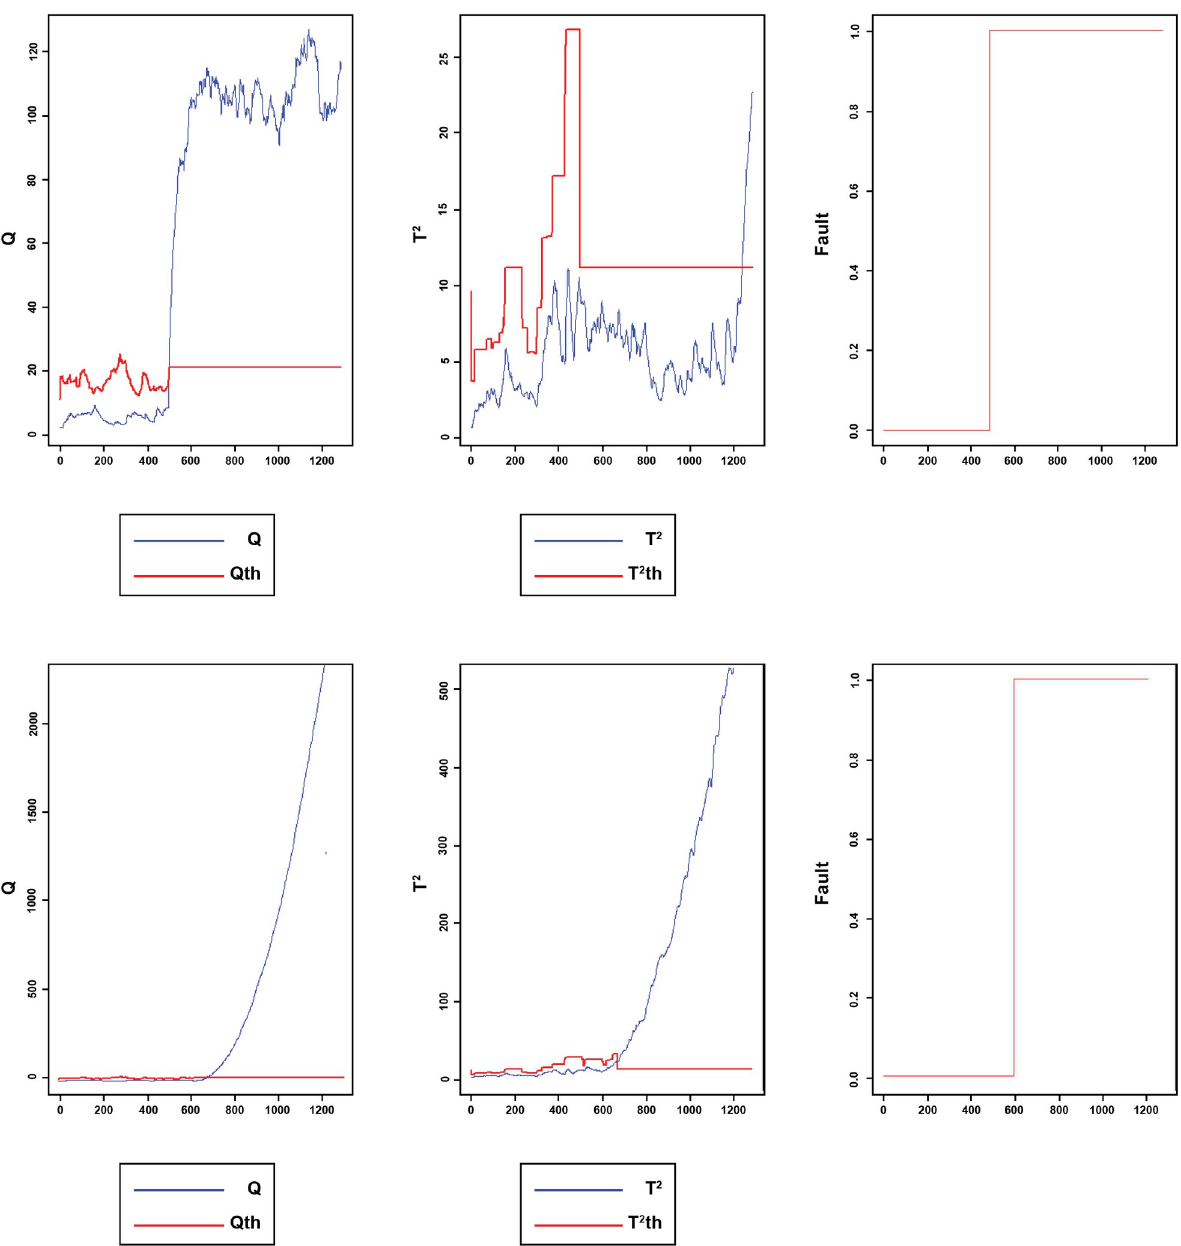
Fig 19. Monitoring performance of MWDPCA for (A) step change (B) slow